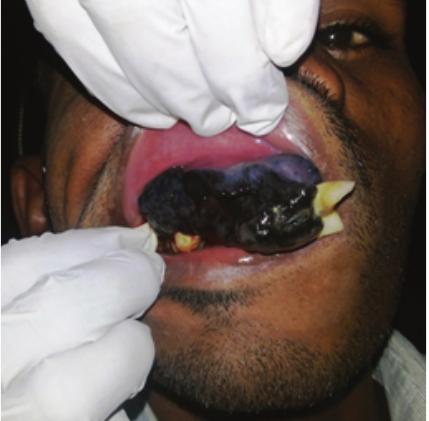
Figure 3: Blackish growth involving entire maxillary anterior alve- olus with displacement of